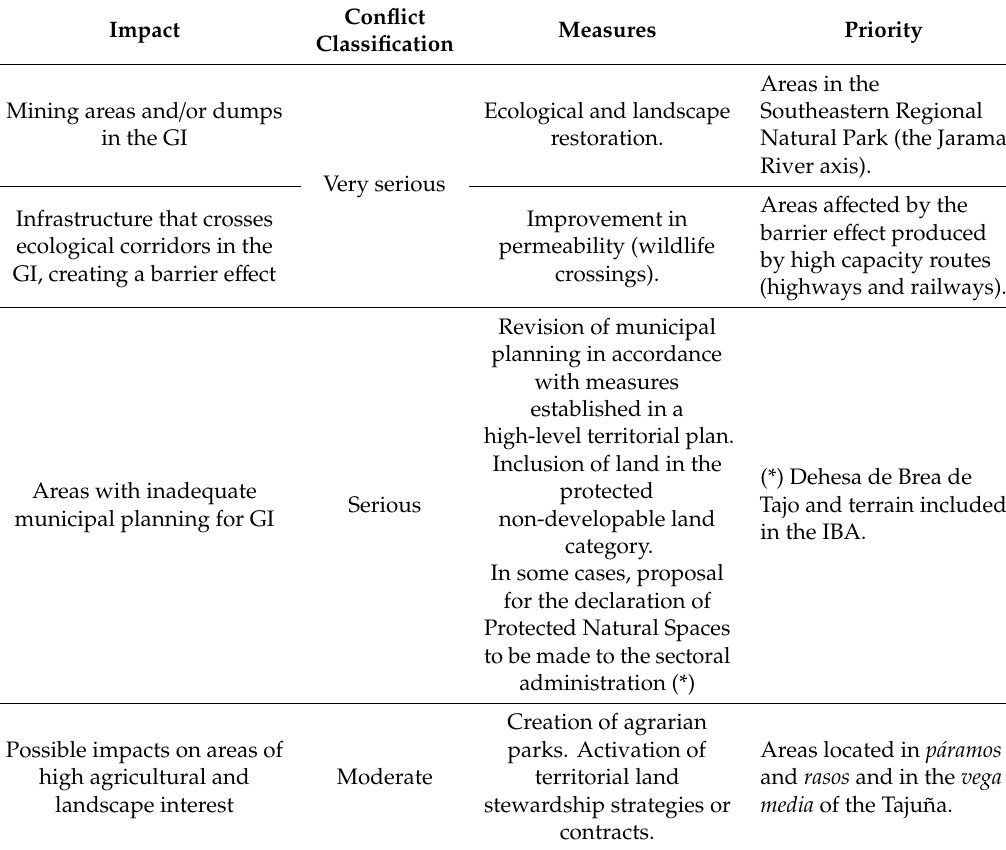
Table 5. Classification of the main territorial conflicts, management measures and priority